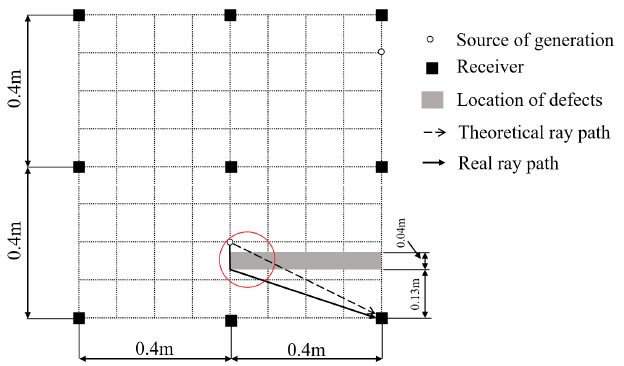
Figure 19. The left side of the defect area with a high velocity in the velocity distribution.